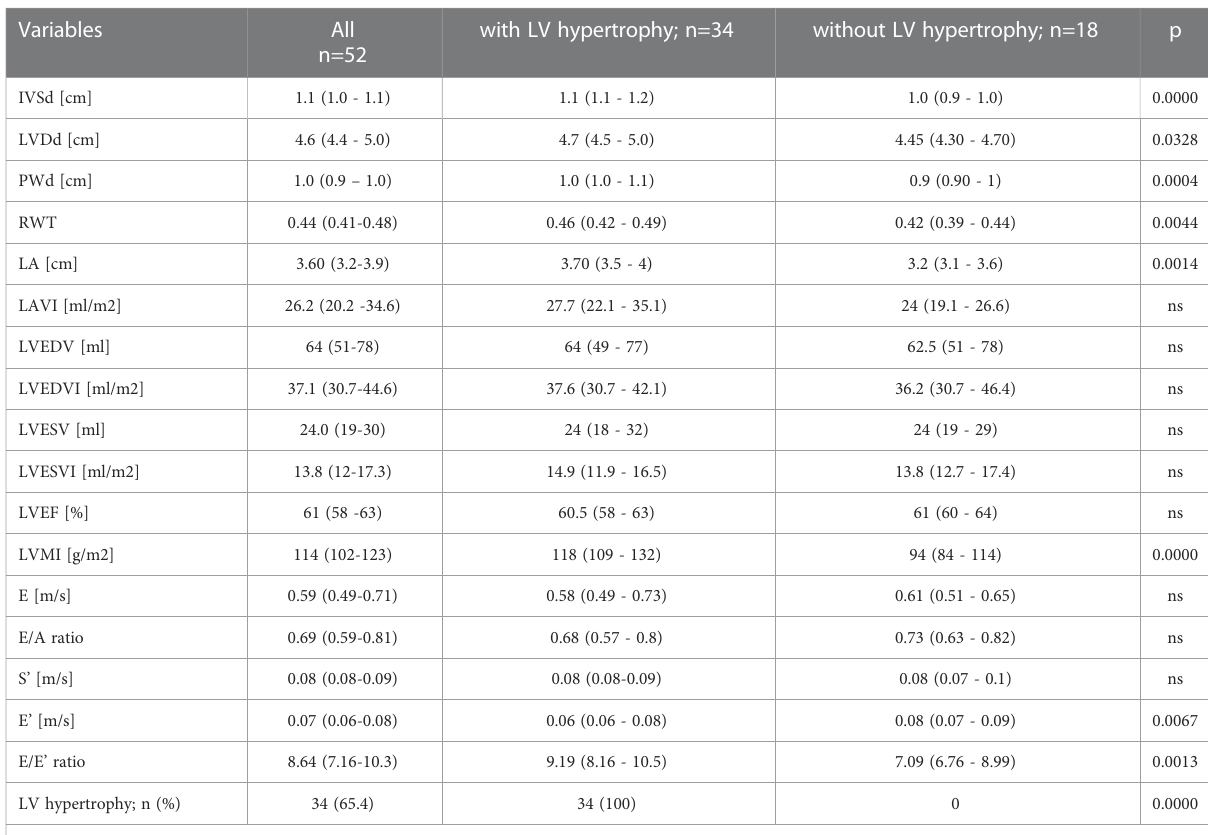
TABLE 2 Echocardiographic characteristics of the study group and divided into a group with and without LV hypertrophy.